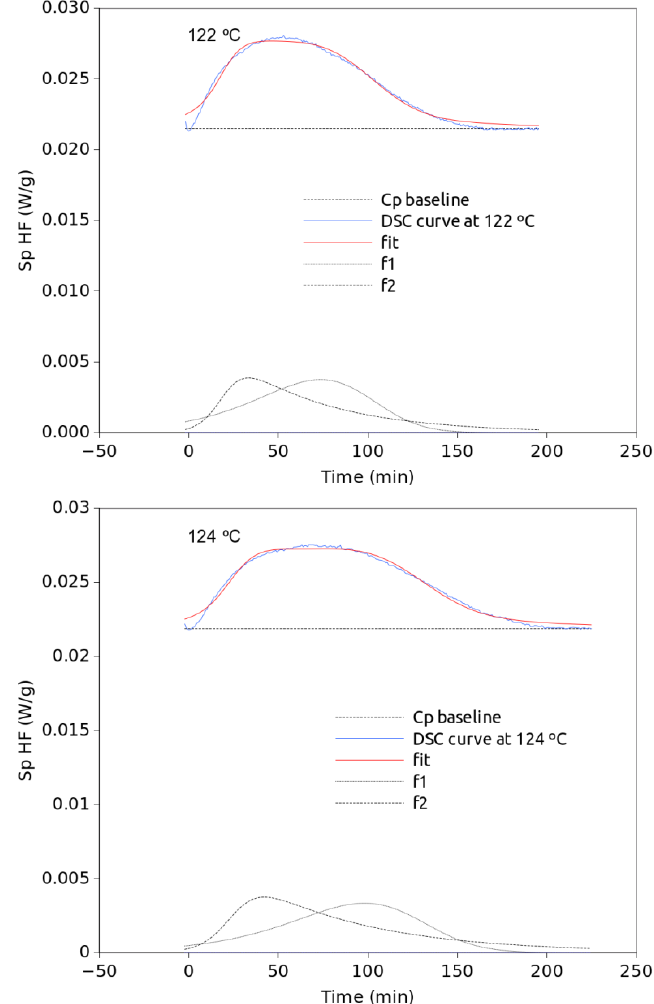
Figure A3. Fittings obtained at all temperatures.